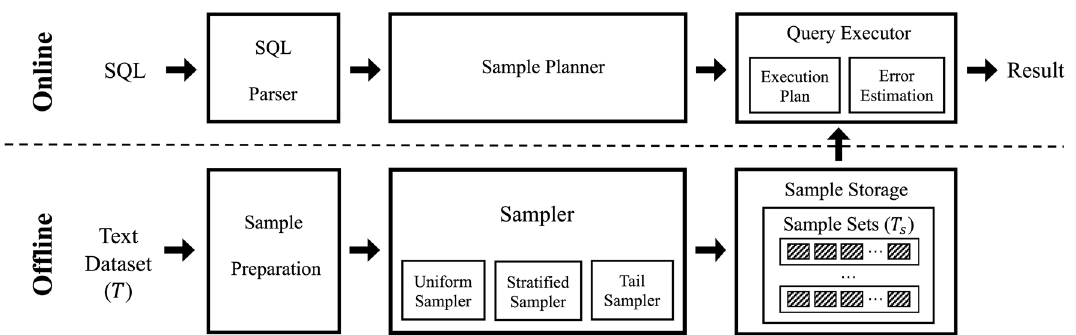
Fig. 1 System overview of